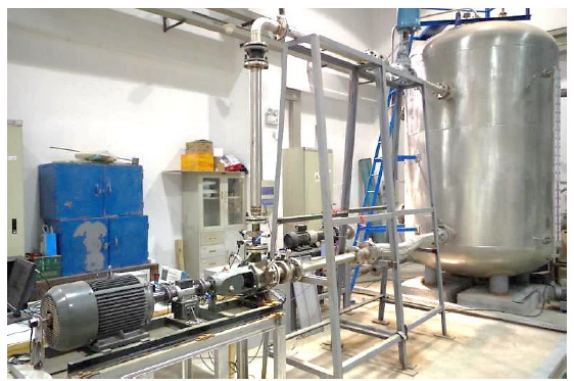
Figure 13. The closed test rig of PAT on pump mode.